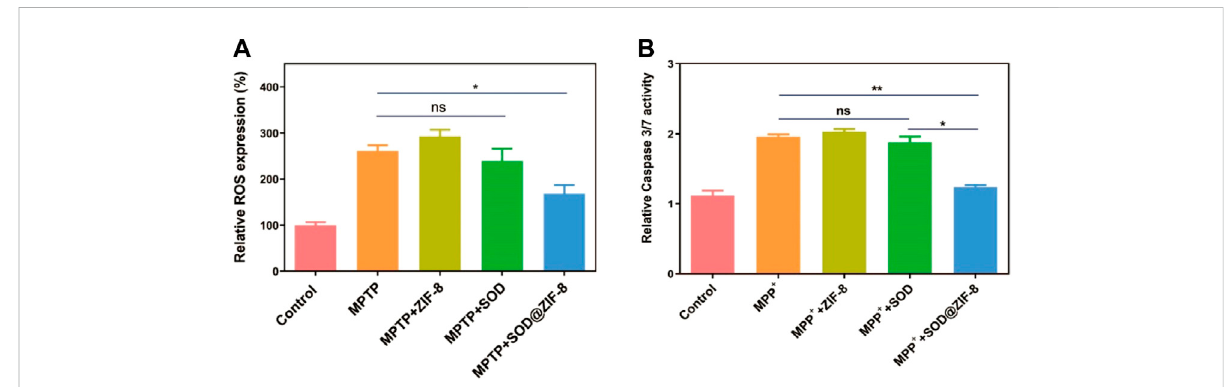
FIGURE 9 ROS scavenging activity of various nanomaterials in MPP + treated SHSY-5Y cells detected by fl ow cytometry with DCFDA-H2 dye (A) and the detection of apoptosis by measuring the activity of effector caspase-3/7 (B)